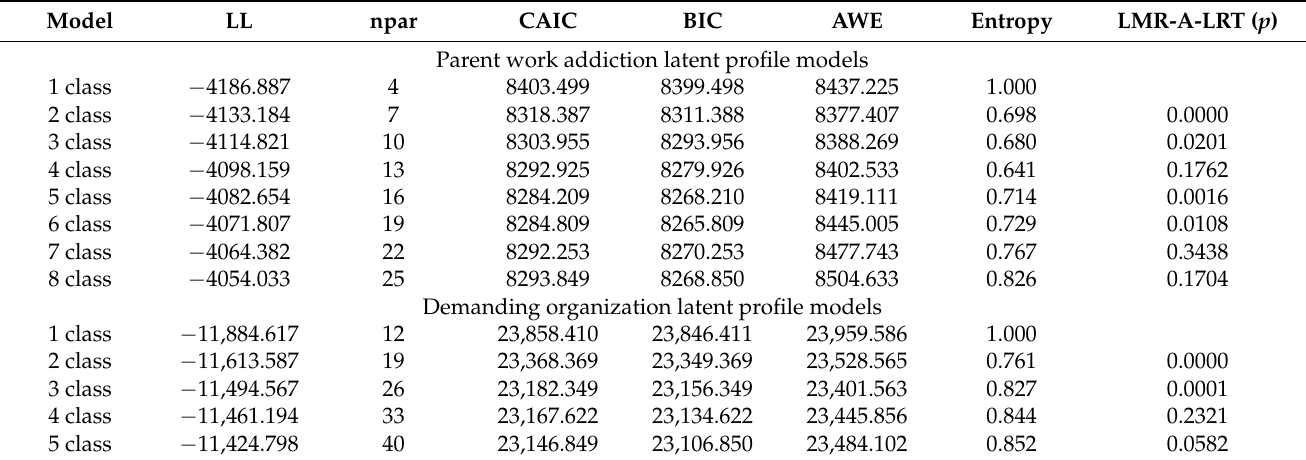
Table 3. Fit indices, entropy, and comparison of estimated latent profile